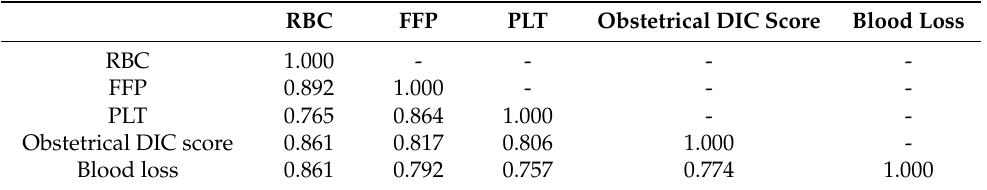
Table 5. Correlation coefficient of RBC, FFP, PLT, obstetrical DIC score, and blood loss.